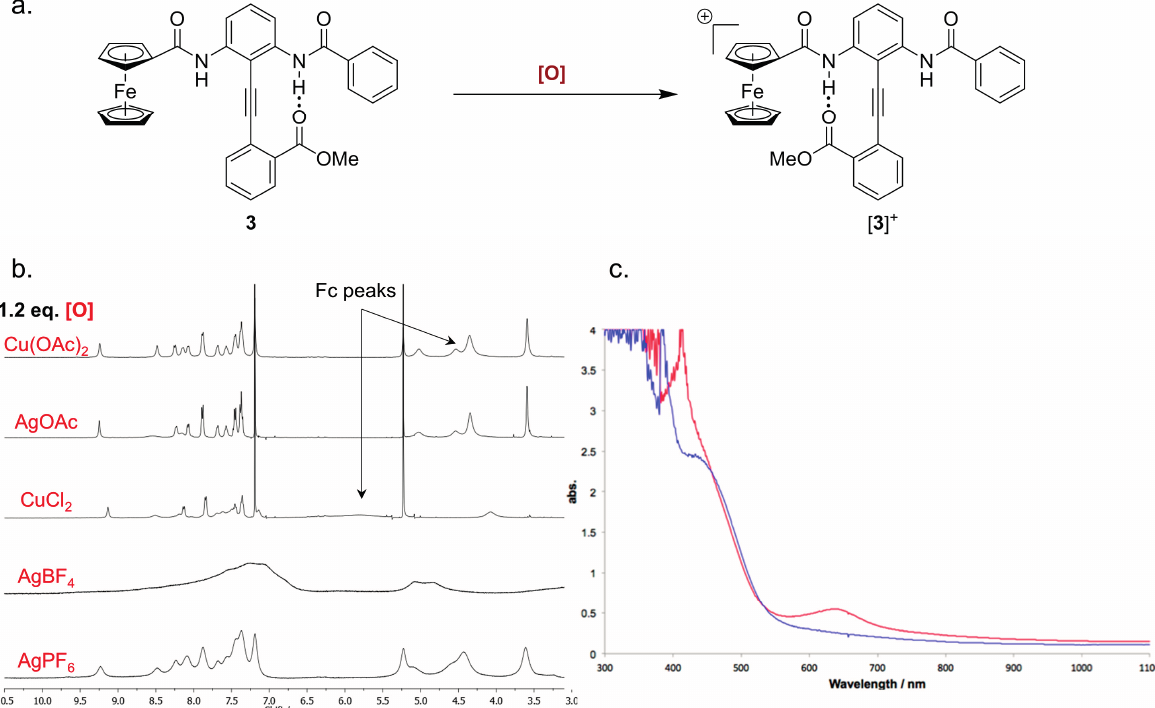
, peak 3 (4.0 mM, CH Cl , see 2 2 2